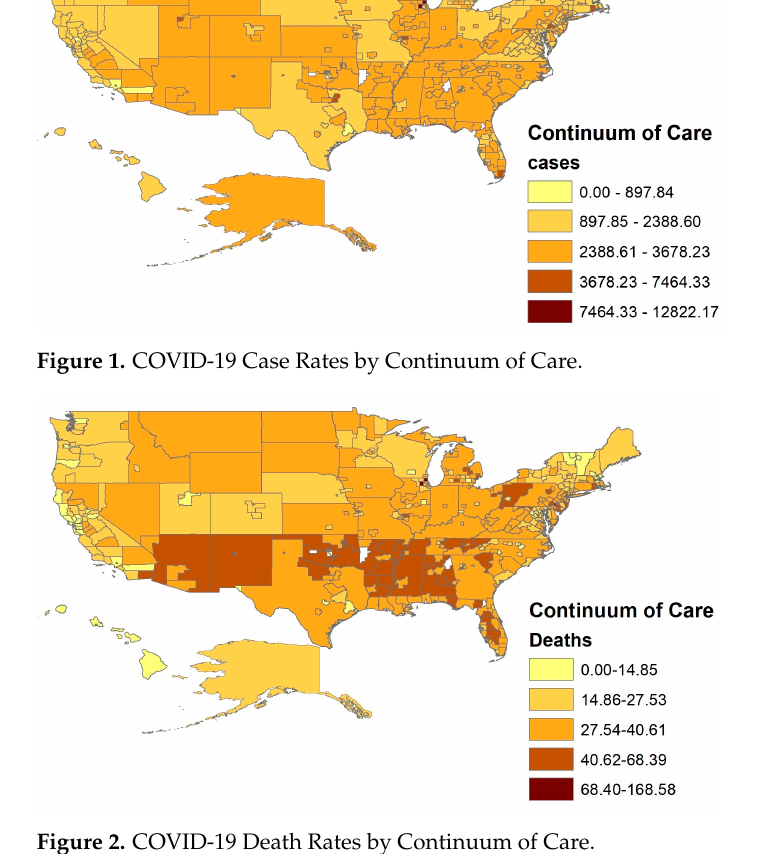
Table 1. Descriptive Statistics at the Continuum of Care Level.